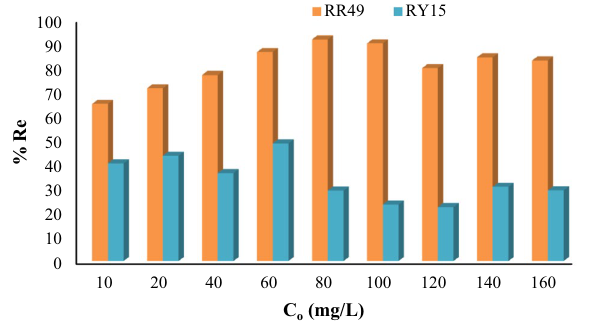
Fig. 3 Effect of primary dye concentration on %Re